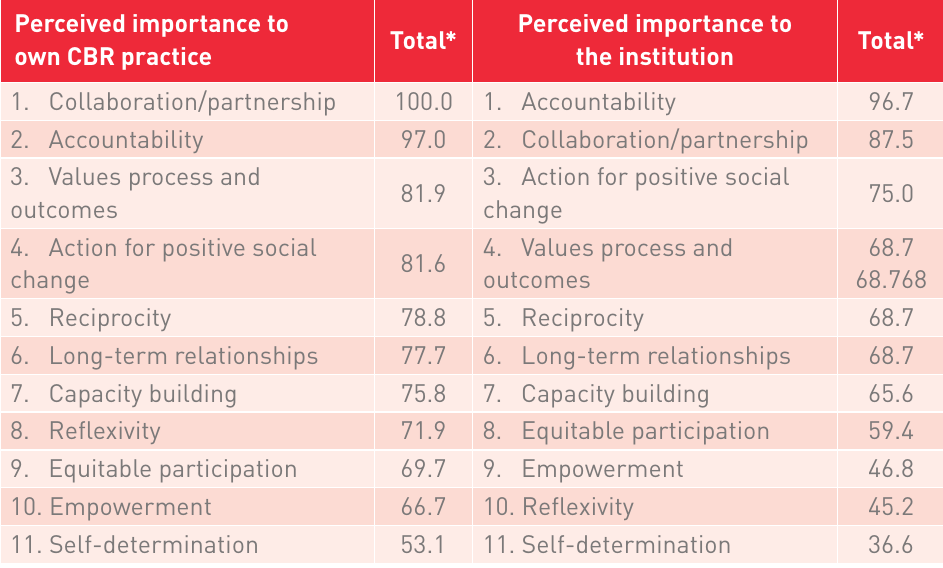
Percentage ranking of importance for VP